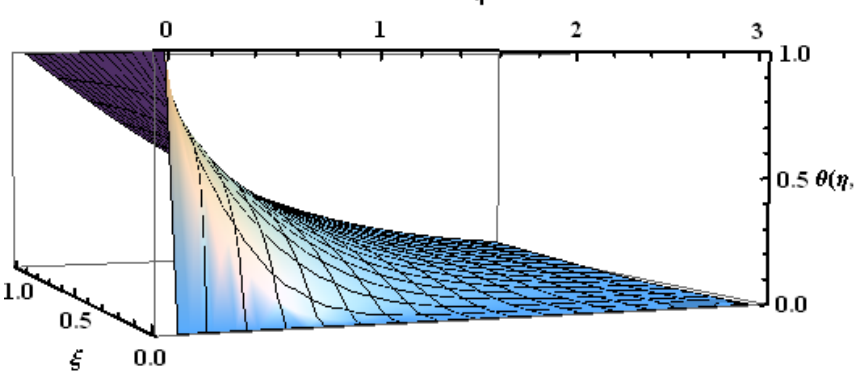
Figure 3. Surface of θ ( ξ , η ) for ξ ∈ [ 0,1 ] and for η ∈ [ 0, ∞ ] .